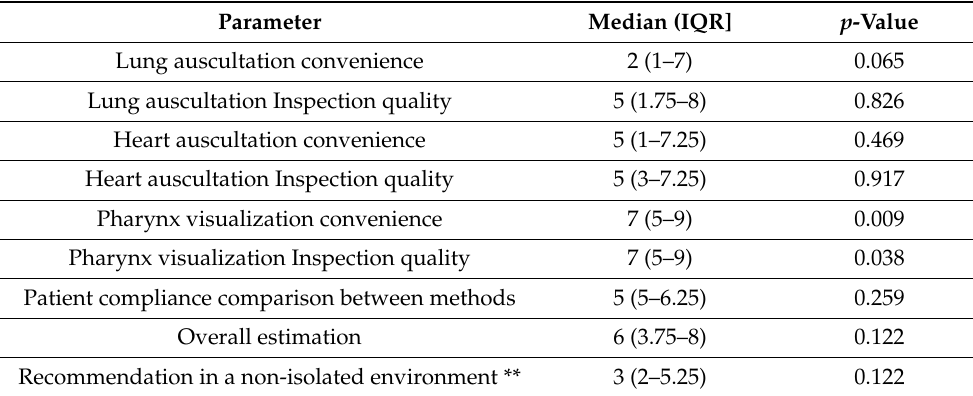
Table 2. Physicians’ differential preferences for examination modalities: score of 5 marking indif- ference between modalities while 1 indicates a major preference in favor of the standard physical examination and 9 indicated a major preference in favor of the TytoCare ®